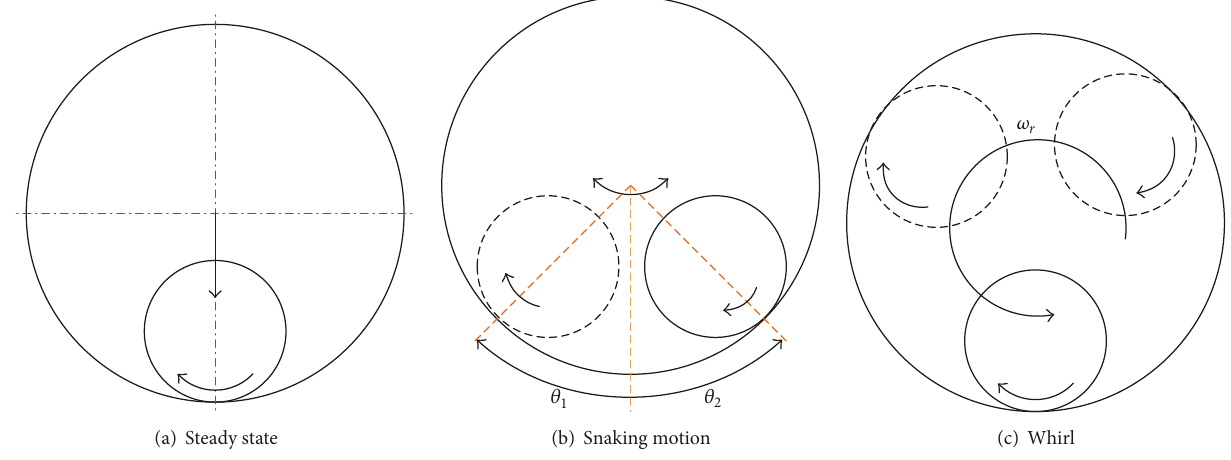
Figure 1: Schematic diagrams of three kinds of buckling